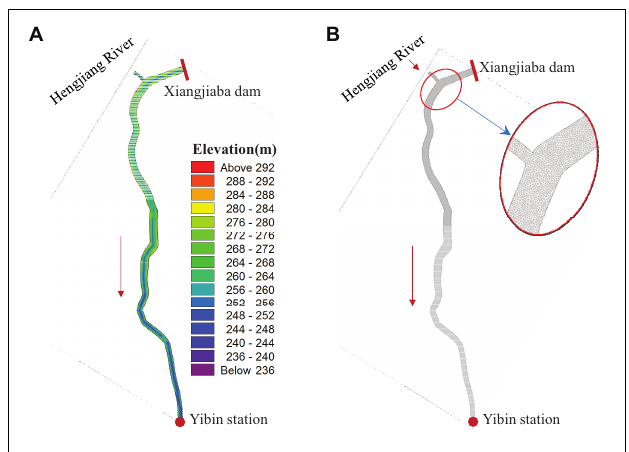
FIGURE 3 | Topography and grid generation of the hydrodynamic model. (A) Topography. (B) Grid generation.